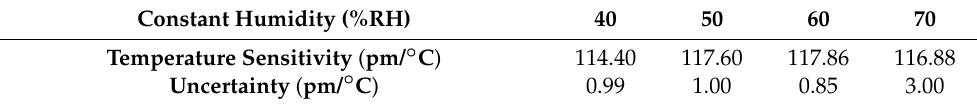
Table 1. Temperature Sensitivity of POFBG (pm/ ◦ C) at different humidities (% RH).